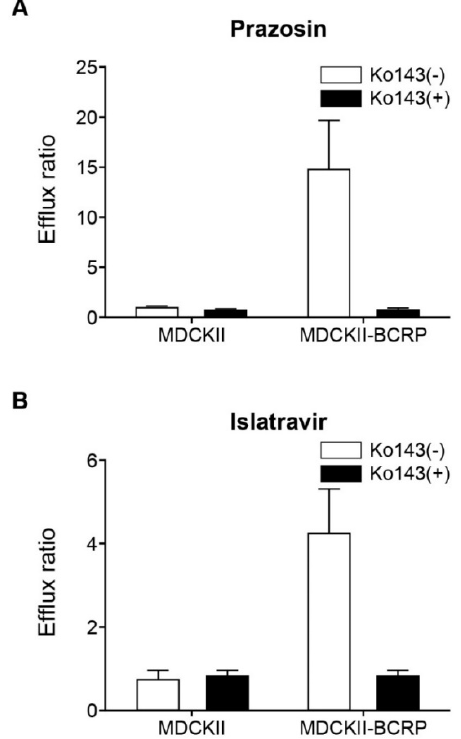
Figure 4. Bidirectional transport of islatravir across MDCKII and MDCKII-BCRP cell monolayers. ( A ) Positive control, efflux ratio of 1 µ M prazosin across MDCKII and MDCKII BCRP cell monolayers, in the presence and absence of 5 µ M Ko143 (control inhibitor). ( B ) Efflux ratio of 2 µ M islatravir across MDCKII and MDCKII-BCRP cell monolayers after 3-h incubation, in the presence and absence of 5 µ M Ko143. Efflux ratio: P app (B to A)/P app (A to B). The experiment was performed in triplicate, except for prazosin in MDCKII without Ko143 ( n = 2). All data are mean ± SEM. BCRP, breast cancer resistance protein; SEM, standard error of the